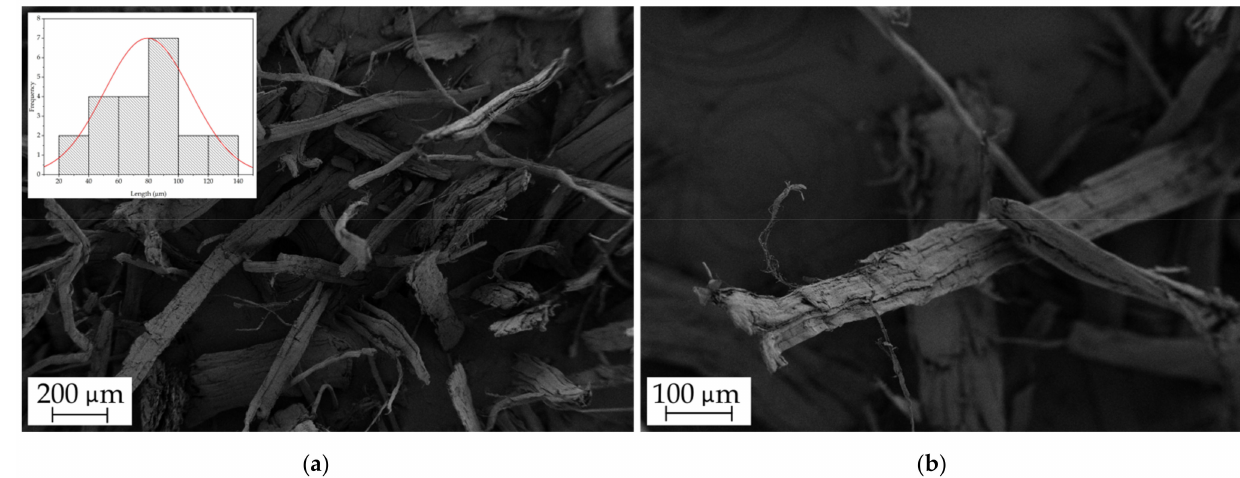
Figure 1. FESEM images of short hemp fiber at ( a ) 50 × with a scale marker of 200 µ m with a fiber fineness histogram and ( b ) 125 × with a scale marker of 100 µ m.